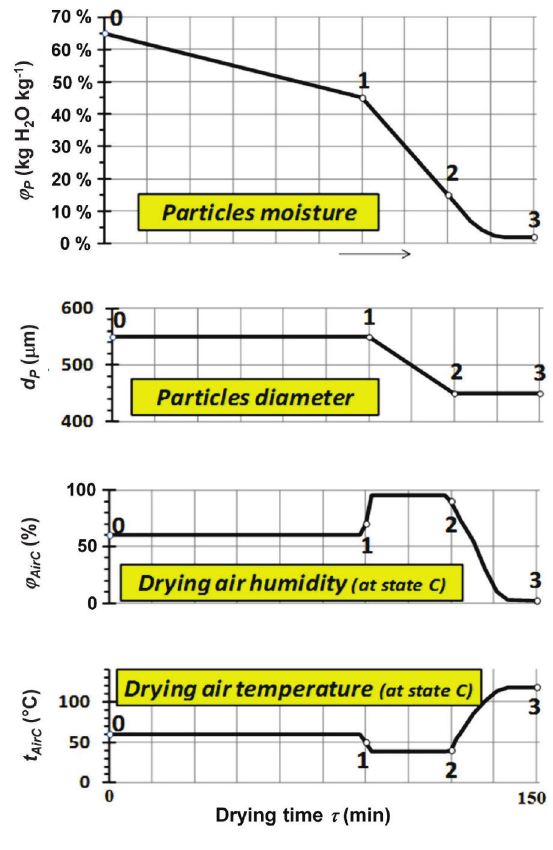
Fig. 8 – Time dependence parameters of particles and drying air throughout the drying process (point C – see Figs. 2 and 4)